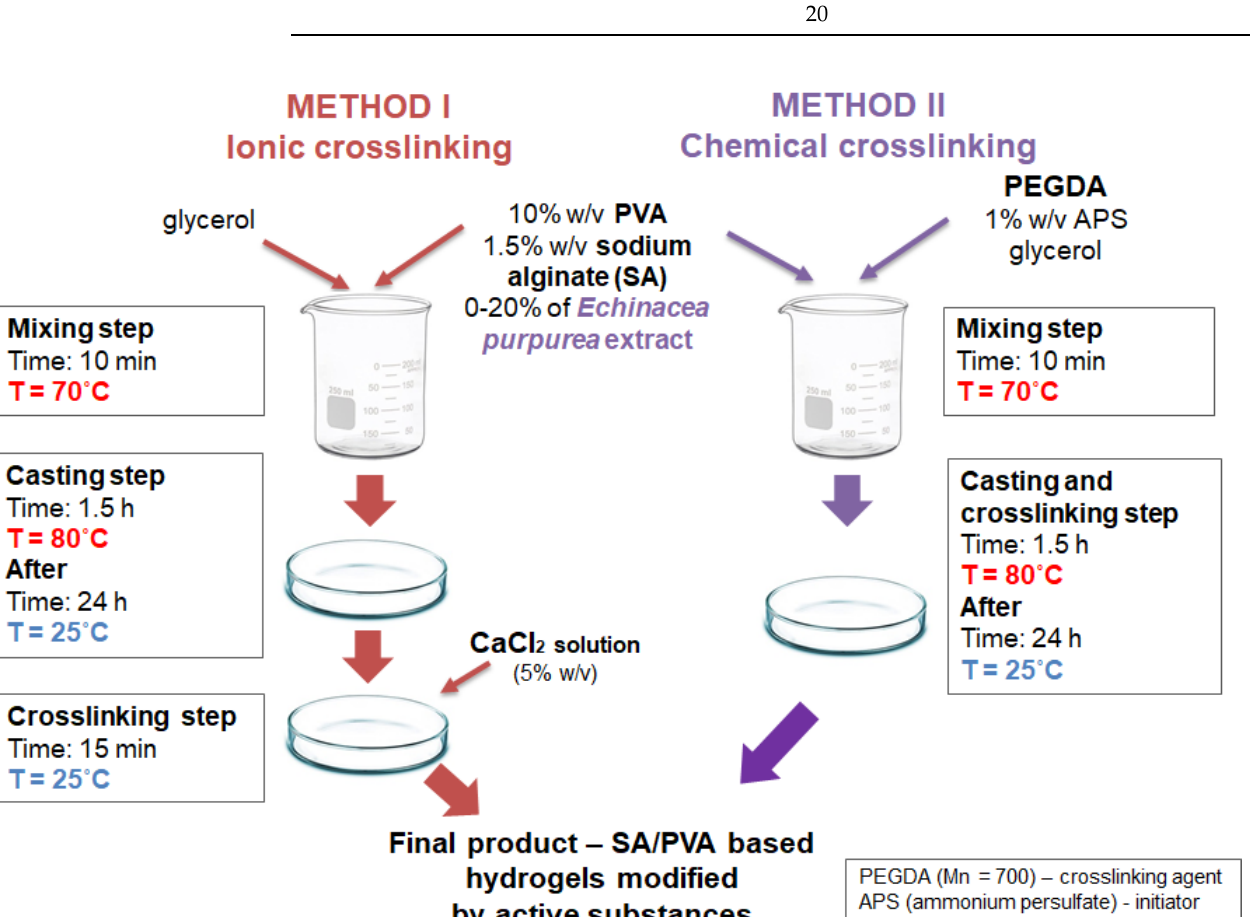
Figure 9. Scheme of preparation procedure. Table 1. Compositions of SA/PVA/ EP hydrogels.